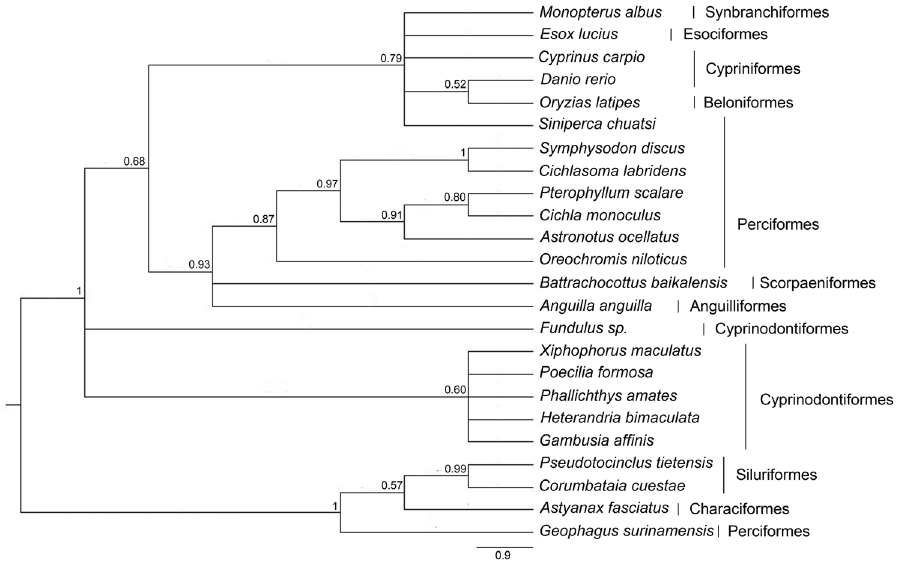
Figure 7. Phylogenetic placements of partial nucleotide sequences of Rex3 from 24 teleosts. Support values at each node are Bayesian posterior